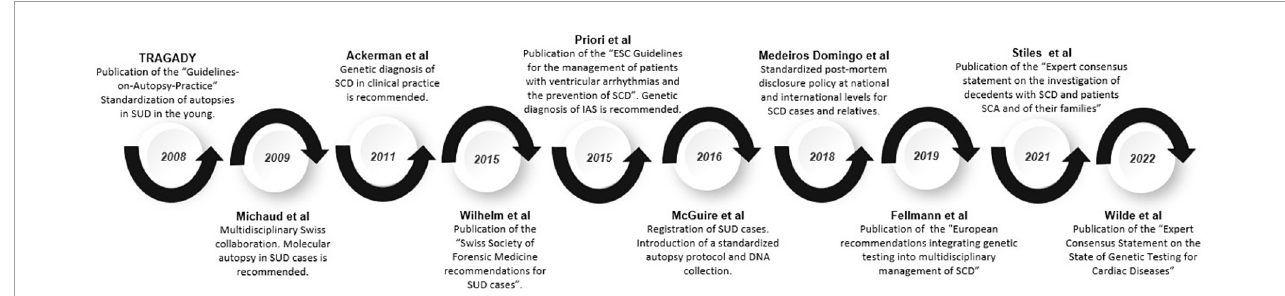
FIGURE3 Timeline of guidelines and recommendations. Evolution of guidelines and recommendations on genetic testing and the standardization of molecular autopsy for the study of patients affected with SUD and their relatives.